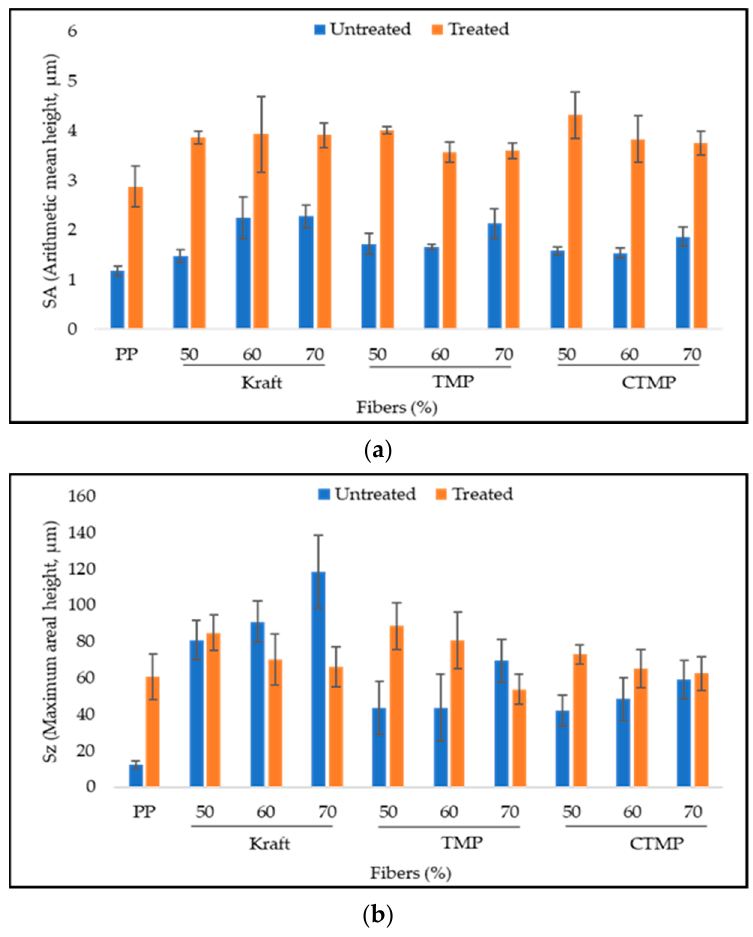
Figure 4. Evolution of surface roughness parameters (3D) of PP-based composites before and after chromic treatment: ( a ) arithmetic mean height evolution and ( b ) maximal areal height evolution.